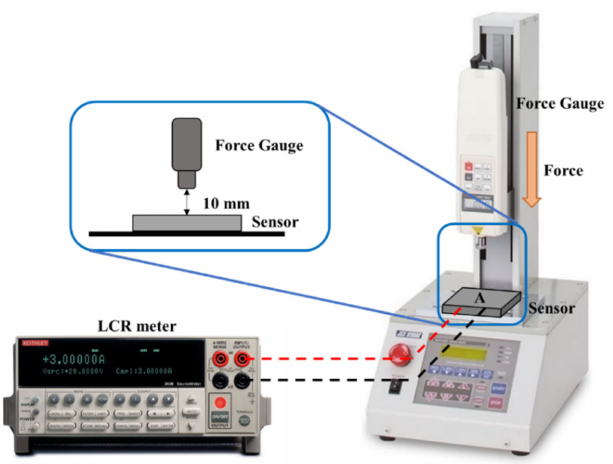
Figure 6. Schematic of the static normal force measurement